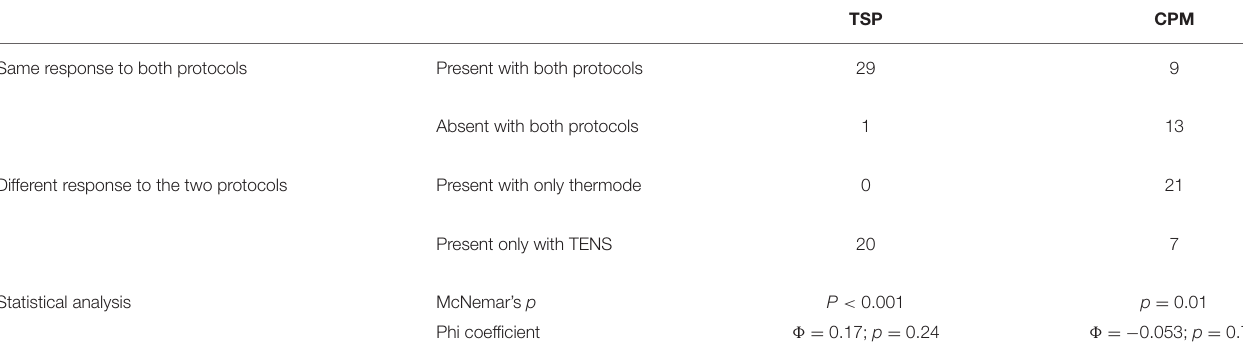
TABLE 1 | TSP and CPM scores (continuous variables) were transformed into “present/absent” scores (dichotomic variables).